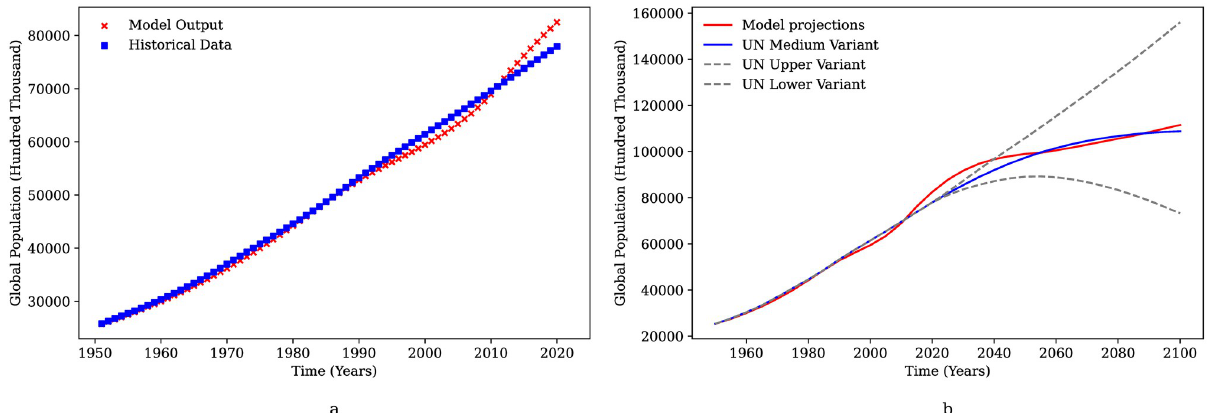
Fig 3. Global population trends. a : Comparison of the population predicted by GGSM denoted by “Model Output” to the historical global population. b : Human population from GGSM compared to projections for the global population growth from the UN world population insights report (1950- 2100).